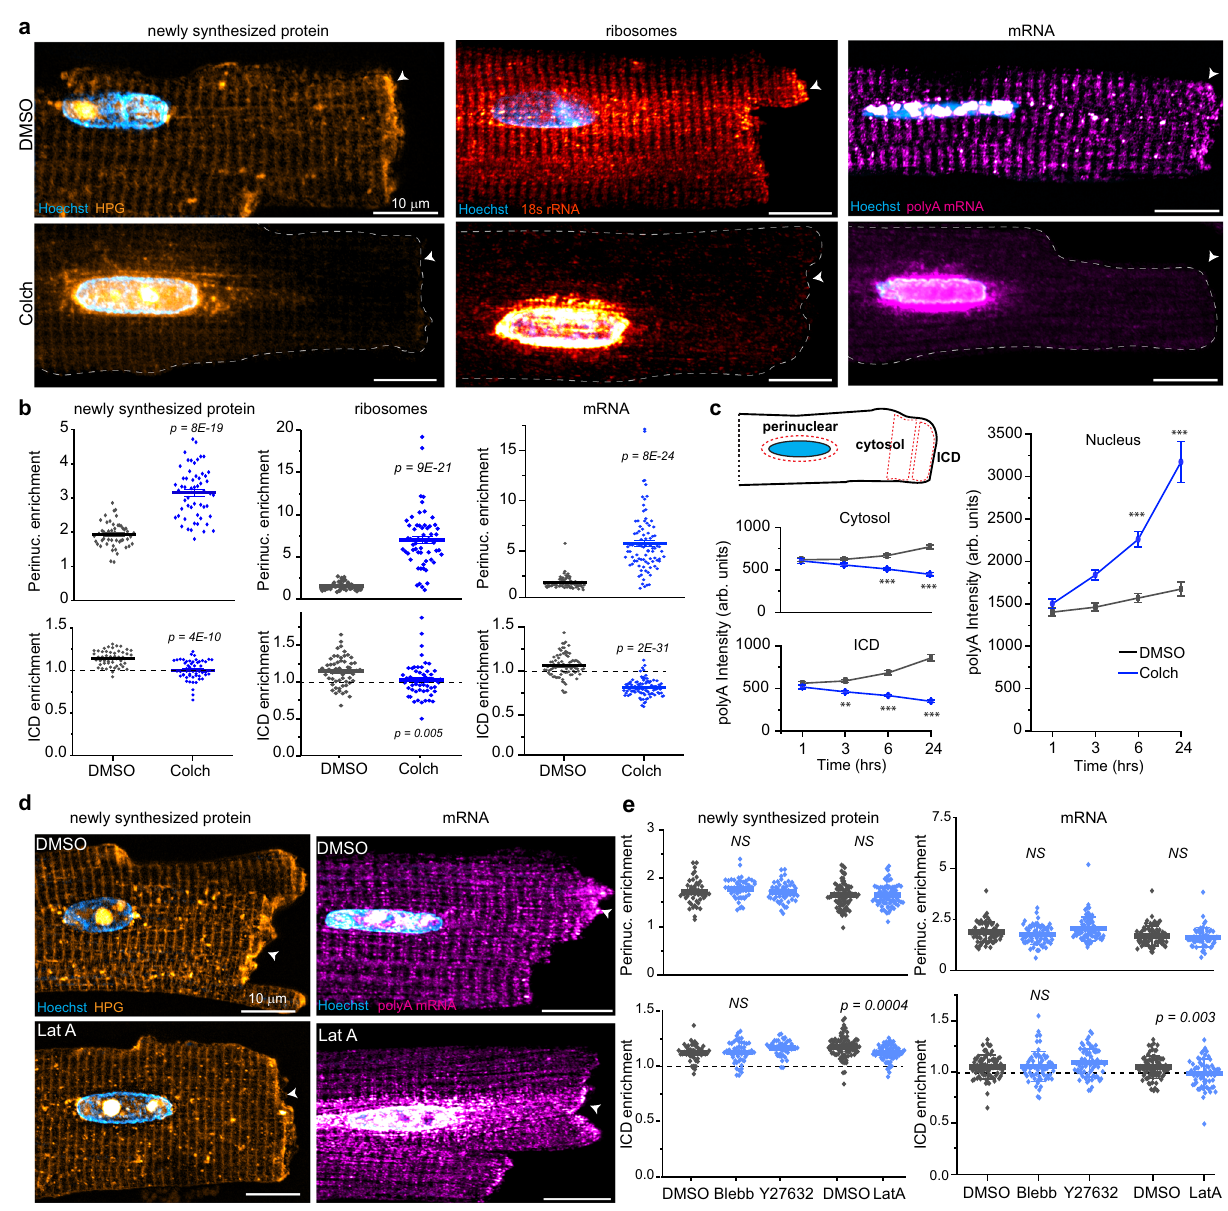
Fig. 4 Microtubules control the localization of mRNA, ribosomes, and new protein synthesis. a Representative images of (left) newly synthesized protein, (middle) ribosomes and (right) mRNA in (top) DMSO or (bottom) Colch-treated ARVMs. White arrow indicates ICD. b Nuclear:cytosolic and ICD: cytosolic ratios of mean fl uorescence intensities of experiments shown in a . Newly synthesized protein: DMSO ( N = 3, n = 52), Colch ( N = 3, n = 55); ribosomes: DMSO ( N = 2, n = 54), Colch ( N = 2, n = 57; mRNA: DMSO ( N = 3, n = 82), Colch ( N = 3, n = 90). Statistical signi fi cance determined via two sample, two-tailed t -test. c Cartoon (left, top) depicting representative placement of perinuclear, cytosolic, and ICD ROIs for analysis in b and c . Mean polyA fl uorescence intensity in the cytosol (left, middle), ICD (left, bottom), and nucleus (right) as a function of time. DMSO, n = 47 (1 h), n = 51 (3 h), n = 54 (6 h), n = 40 (24 h). Colch, n = 49 (1 h), n = 47 (3 h), n = 50 (6 h), n = 47 (24 h). Statistical signi fi cance determined via one-way ANOVA with post hoc Bonferroni comparison. d Representative images of (left) newly synthesized protein and (right) mRNA in (top) DMSO or (bottom) Latrunculin A- treated ARVMs. White arrow indicates ICD. e Nuclear:cytosolic and ICD:cytosolic ratios of mean fl uorescence intensities of experiments shown in d . Newly synthesized protein: DMSO ( N = 2, n = 46), Blebb ( N = 2, n = 49), Y27632 ( N = 2, n = 48), DMSO ( N = 3, n = 82), LatA ( N = 3, n = 80); mRNA: DMSO ( N = 3, n = 70), Blebb ( N = 3, n = 63), Y27632 ( N = 3, n = 74), and DMSO ( N = 3, n = 77), LatA ( N = 3, n = 59). Statistical signi fi cance determined via one-way ANOVA with post hoc Bonferroni comparision (DMSO, Blebb, Y27632) and two sample, two-tailed t -test (DMSO, LatA). For all graphs shown in fi gure, the mean line is shown, with whiskers denoting standard error (SE) from the mean. Source data are provided as a Source data fi